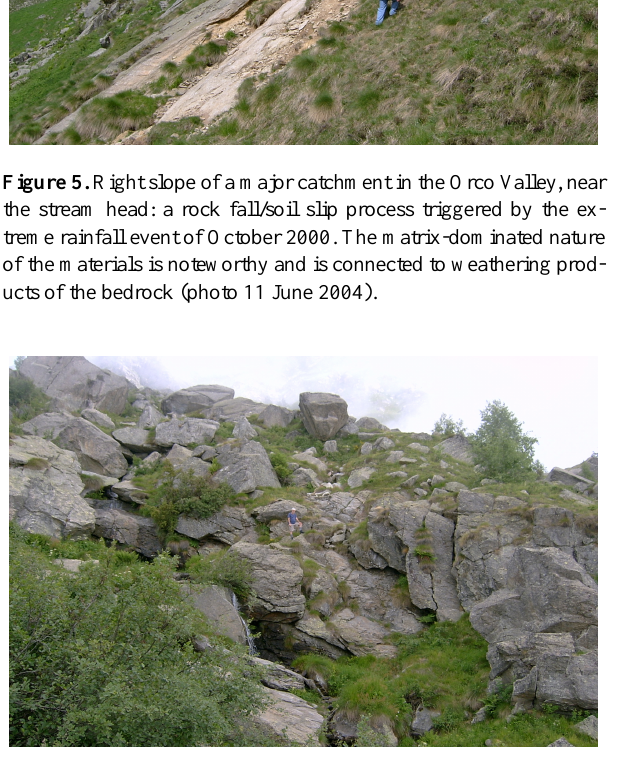
Figure 6. In a steep-sloping sub-catchment in the upper Orco Val- ley, the right slope, affected by a deep-seated gravitational process, is underlain by disjointed earth blocks and extremely uneven ground surface (photo 12 July 2004).